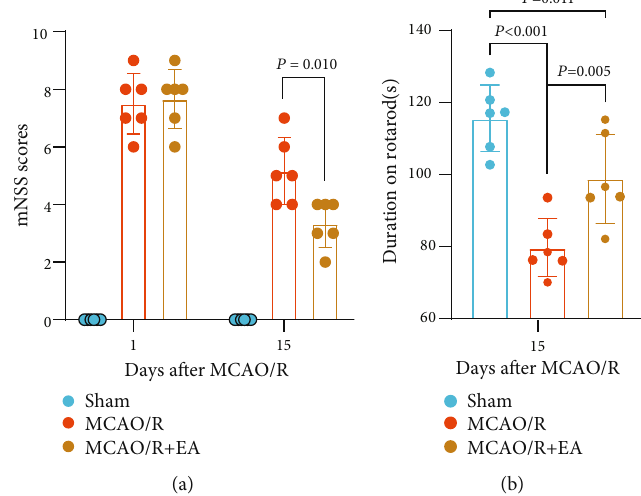
Figure 3: EA treatment positively a ff ected neurological and motor function in MCAO/R rats. (a) The mNSS score of rats after 1 and 15 days of ischemia – reperfusion. The sham group had no neurologic de fi cits during the whole period (score of 0). (b) Performance of all rats at 15 days on the accelerating rotarod. Data are presented as the mean ± standard deviation, n = 6 . Abbreviations: EA: electroacupuncture; MCAO/R: middle cerebral artery occlusion-reperfusion; mNSS: modi fi ed neurological severity